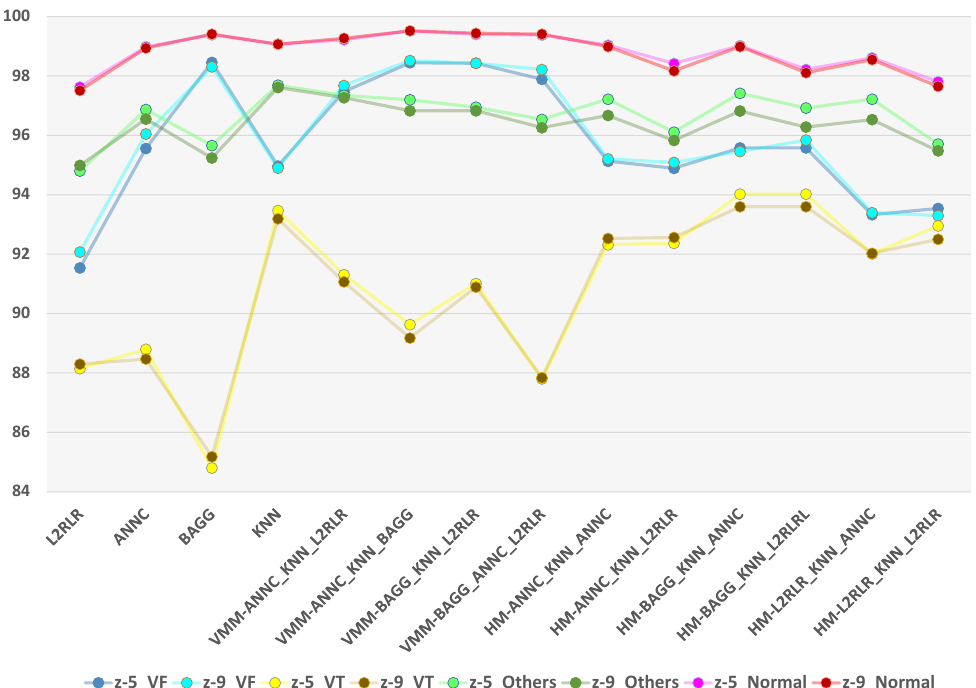
Figure 9. Classification rate for sensibility to each class, for the test dataset using z-5 and z-9 cross validation. Individual and combined VMM and HM classifiers are